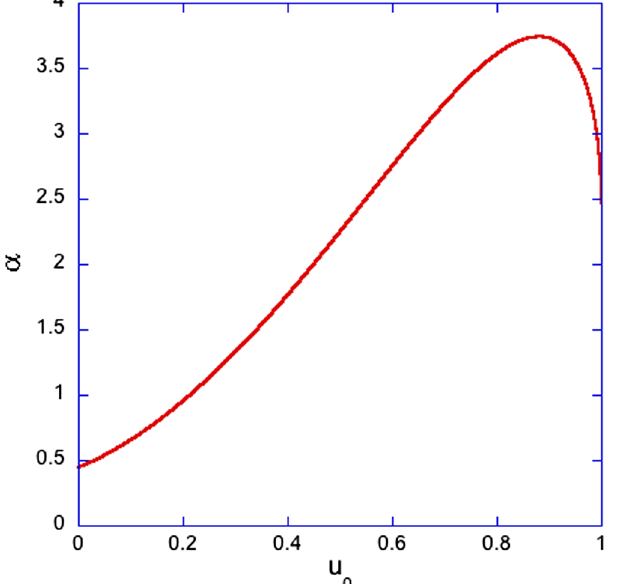
FIG. 7. Value of α ð u 0 Þ , where u 0 ¼ value of the dimensionless potential at the point that the electric field is zero. See the text for the meaning of the symbols in Sec. II B 4.